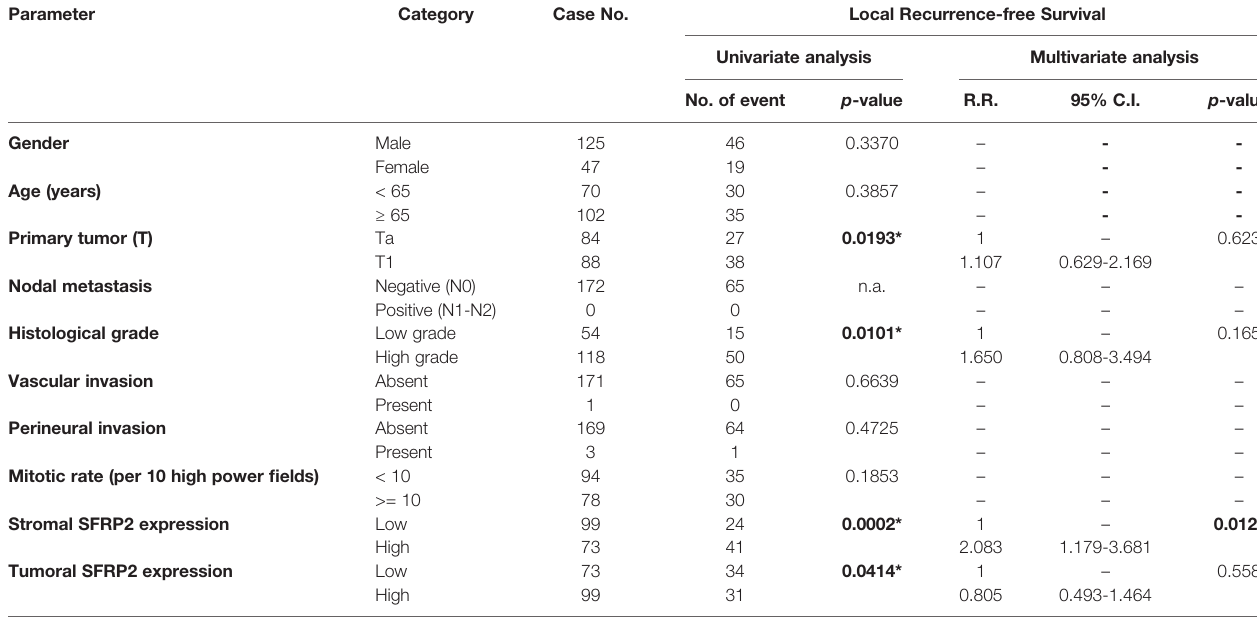
TABLE 6 | Univariate log-rank and multivariate analyses for local recurrence-free survivals in NMIBC post TURBT. Parameter